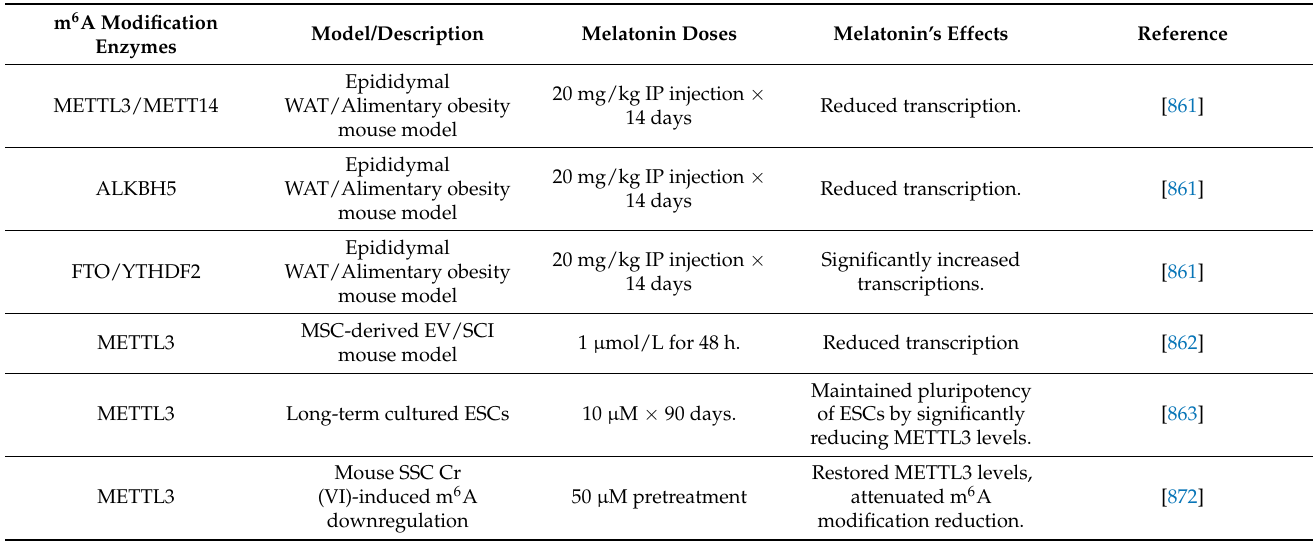
Table 2. In vivo and in vitro effects of melatonin on m 6 A modifications by methyltransferases, demethylases, and